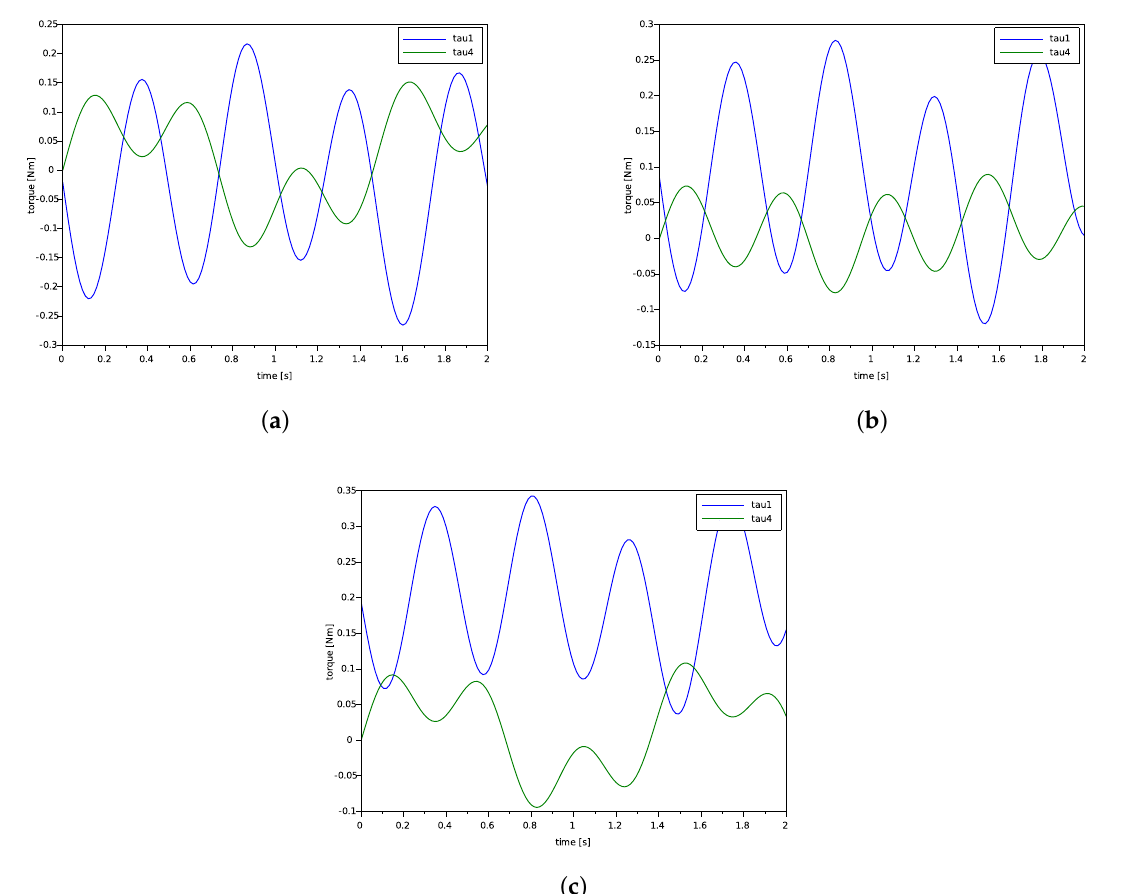
Figure 8. Inverse dynamics: torques of actuators 1 ( τ 1 : tau1) and 4 ( τ 4 : tau4) simulated for subjects of different heights and weights: ( a ) 1.8 m and 80 kg; ( b ) 1.7 m and 60 kg; ( c ) 1.6 m and 50